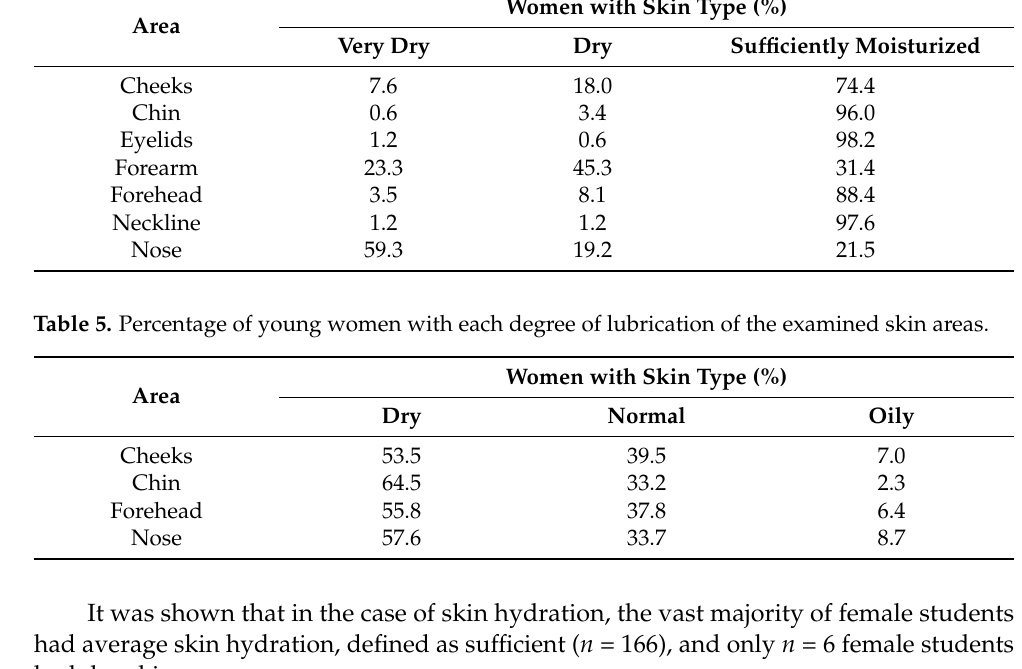
Table 4. Percentage of young women with each degree of hydration of the examined skin areas. Women with Skin Type (%) Area Very Dry Dry Sufficiently Moisturized